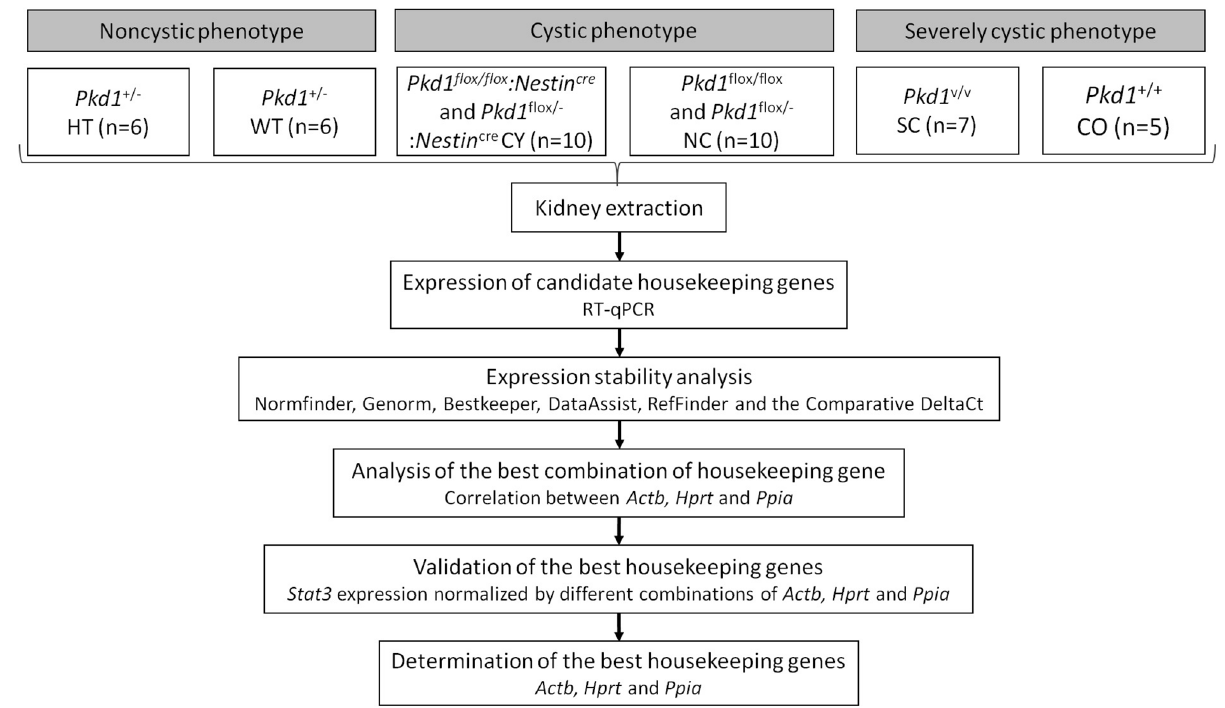
Figure 1. Workflow diagram illustrating the strategy used to identify the best housekeeping normalizer for RT-qPCR studies in Pkd1 -deficient kidneys. To proceed with appropriate comparisons, we included housekeeping genes selected from the available literature ( Actb , Actg1 , B2m , Gapdh , Hprt , Pgam1 and Ppia ). Pkd1 , polycystic kidney disease 1